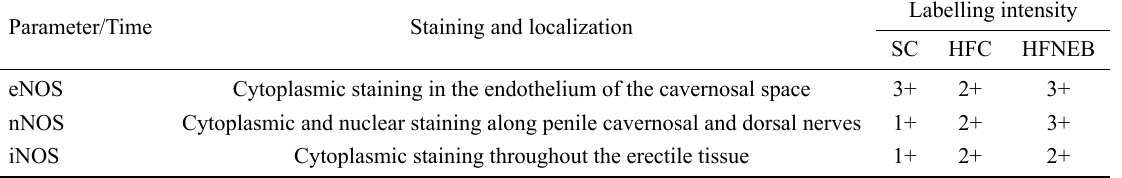
Table 5. Immunolabelling